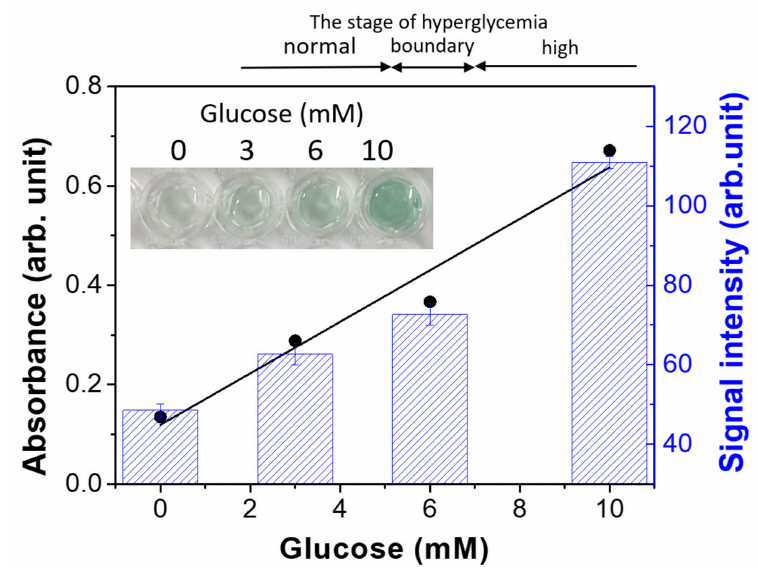
Figure 5. Colorimetric detection of glucose concentration using magnetic hydrogels. Absorbance at 417 nm (black vertical axis) and signal intensity (blue vertical axis) are captured with a smartphone and analyzed in ImageJ. Inset: colorimetric signal generated by di ff erent glucose concentrations.